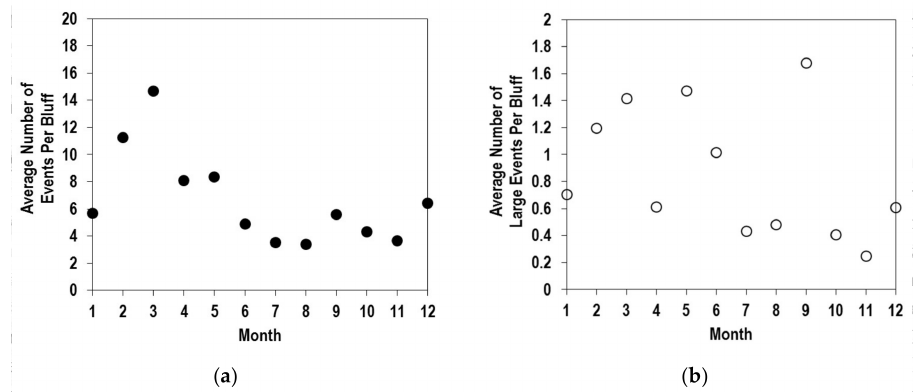
Figure 2. ( a ) Average number of failure days per month for a bluff of average size 250 m 2 (along stream length × height). Number of observations: 2705; ( b ) Average number days with large failures per month. Number of observations: 347. Months are labeled in order from January (1) to December